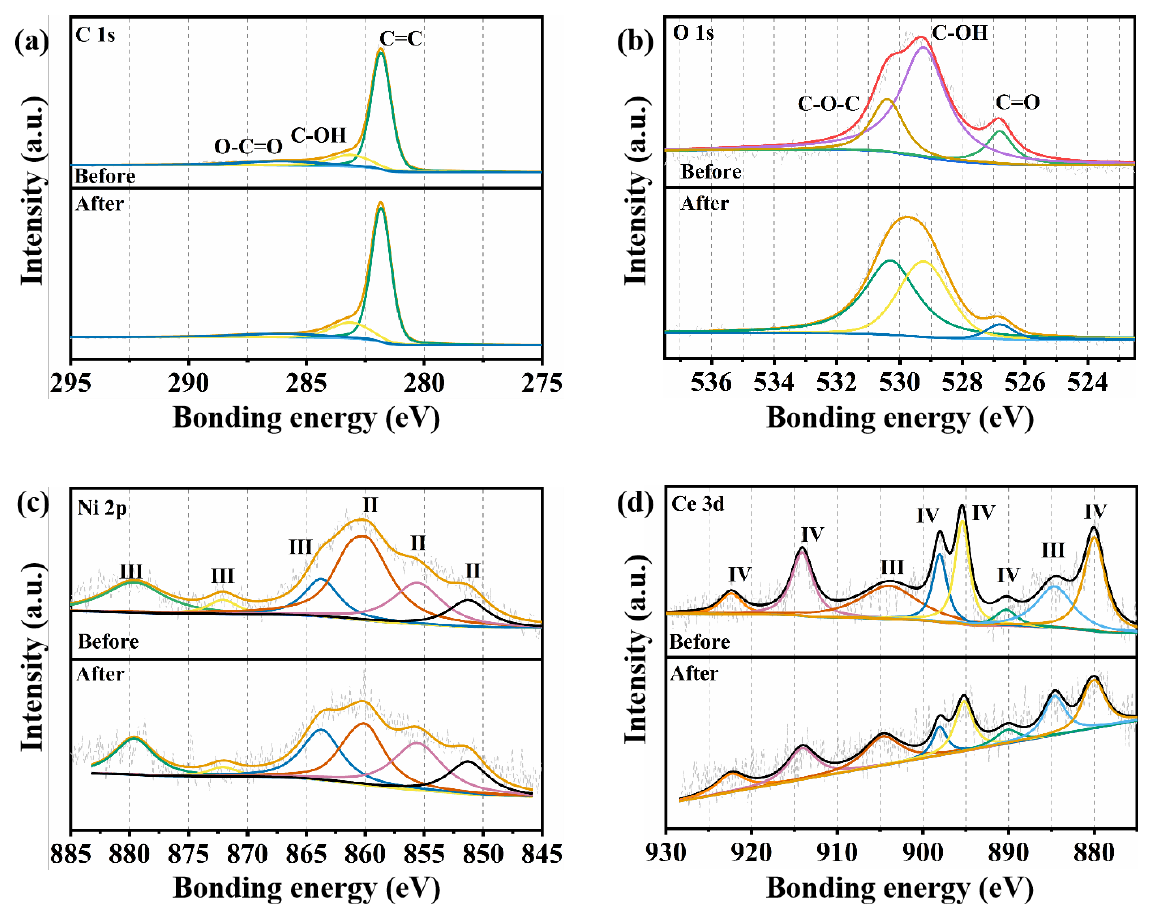
Figure 4. Deconvoluted C 1s ( a ), O 1s ( b ), Ni 2p ( c ), and Ce 3d ( d ) spectra of 0.4(0.4NiO-CeO 2 )-AFS before and after reaction.